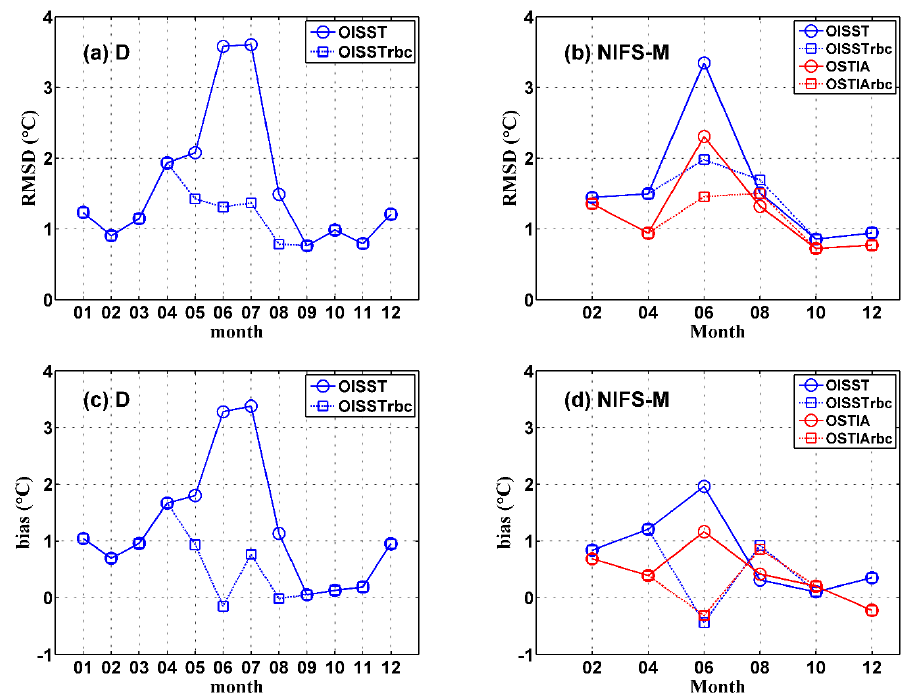
Figure 8. Seasonal variations in the monthly mean ( a , b ) SST RMSD and ( c , d ) bias (°C) between the in situ data (D and NIFS-M) and the gridded datasets (OISST and OSTIA) before and after applying the second bias correction using the in situ CTD observation data. Circle symbols represent the RMSD and bias of the original SST data. Square symbols represent the RMSD of the data corrected using the second bias correction method.